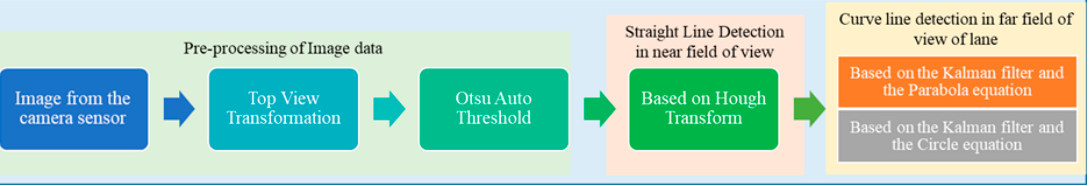
Figure 2. The flow diagram of the lane detection algorithms using the Kalman filter.